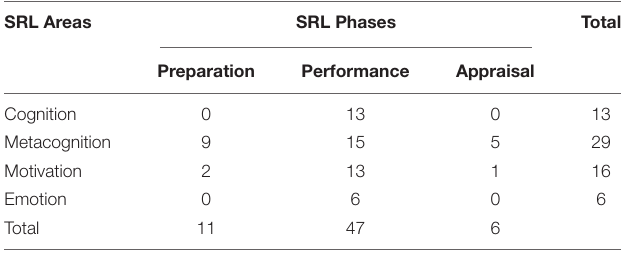
TABLE 2 | Self-regulated learning (SRL) phases and areas targeted by the SRL support interventions 1 .